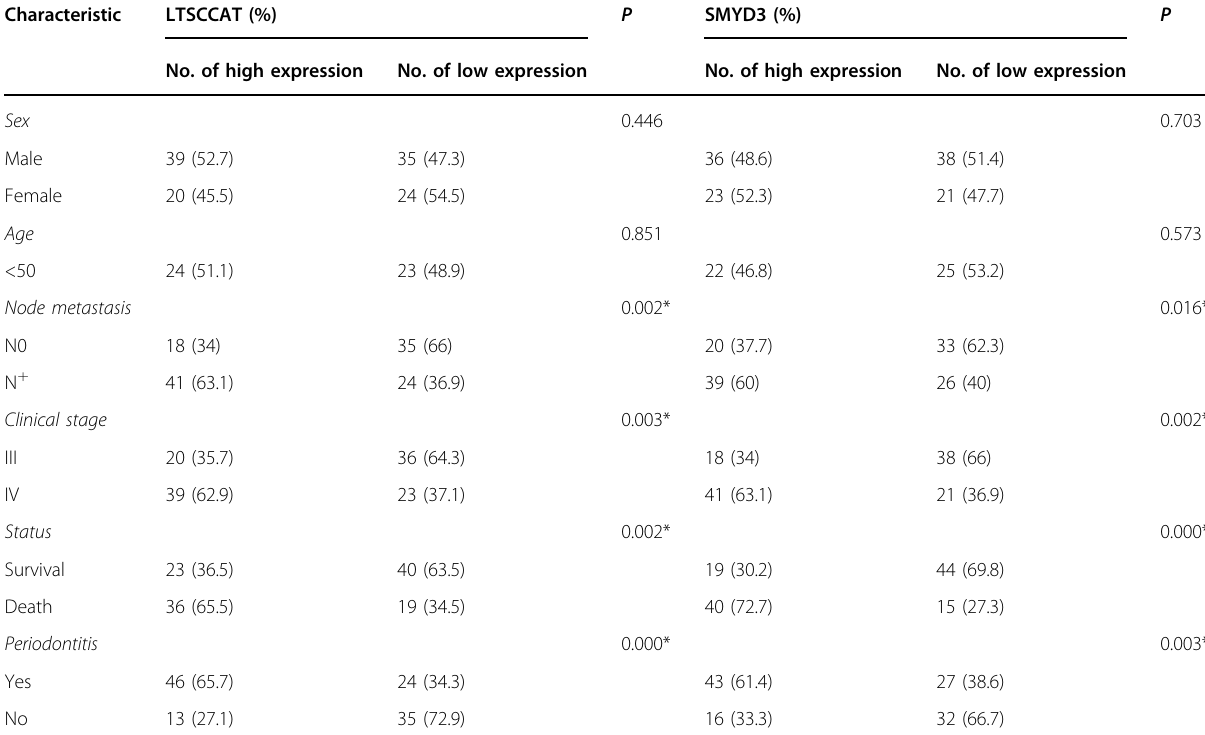
Table 1 Relationship between the expression of LTSCCAT and SMYD3 and tumor stage, lymph node metastasis, and